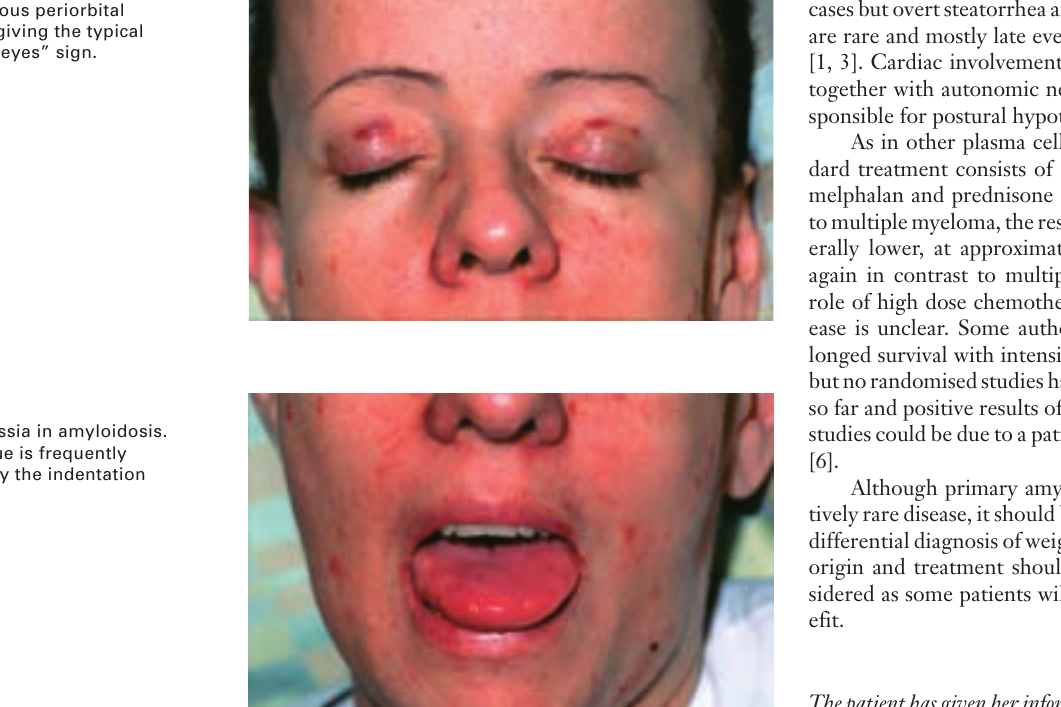
Spontaneous periorbital purpura, giving the typical “raccoon-eyes” sign.